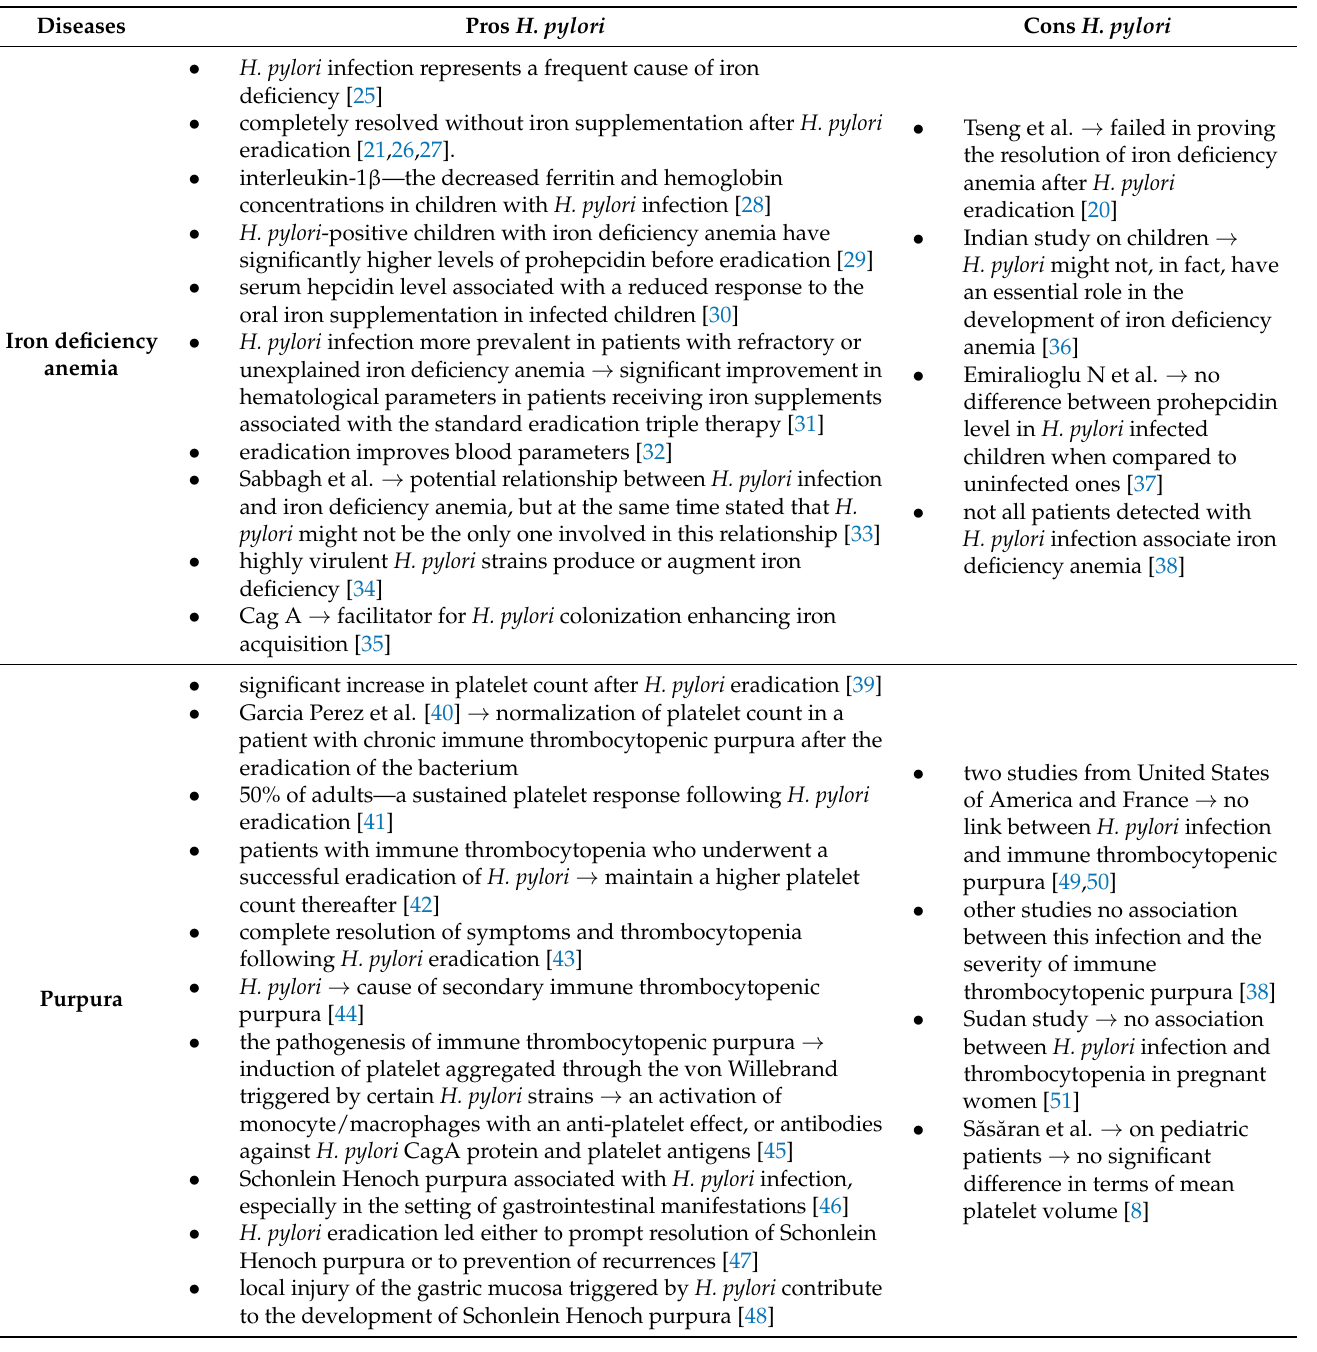
Table 1. H. pylori and extraintestinal manifestations—Pros and